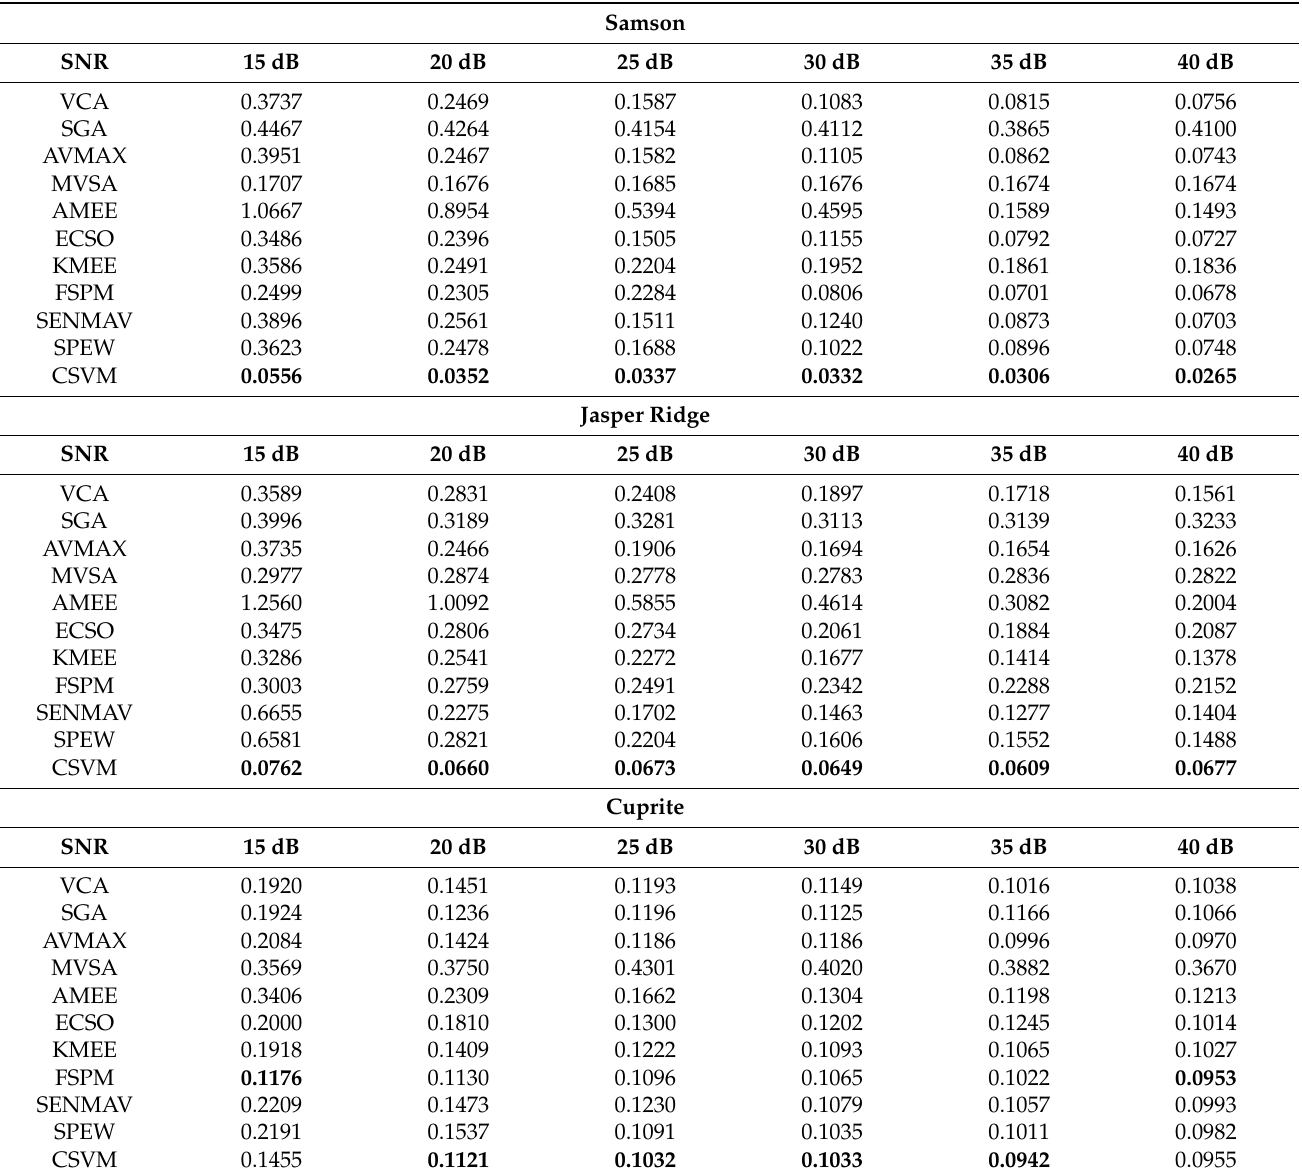
Table 3. The average SAD of all test algorithms on noisy Samson, Jasper Ridge and Cuprite